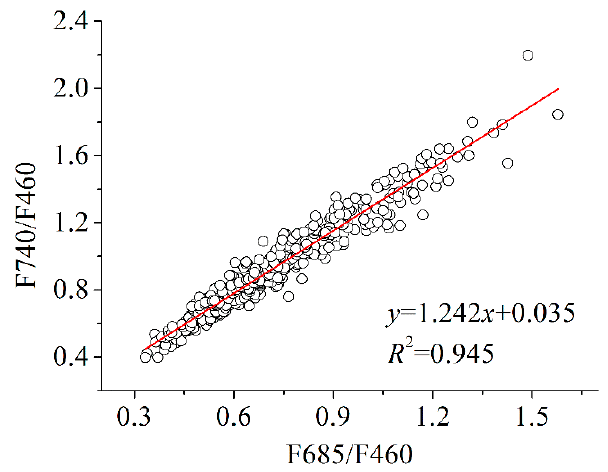
Figure 1. Relationship between the fluorescence characteristics peak intensity at 740 and 685 nm with increasing leaf nitrogen concentration (LNC).